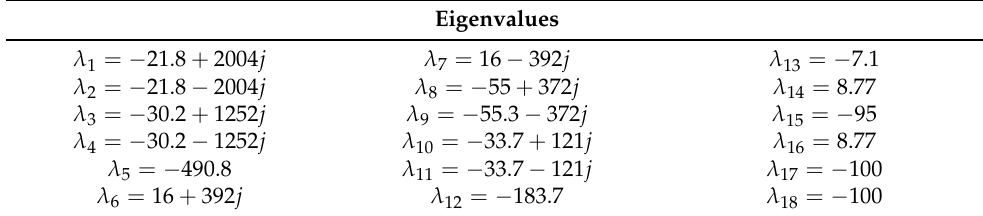
Figure 7. Increasing oscillations due to the torus bifurcation in D q = 380. Table 4. Eigenvalues that occur at the torus